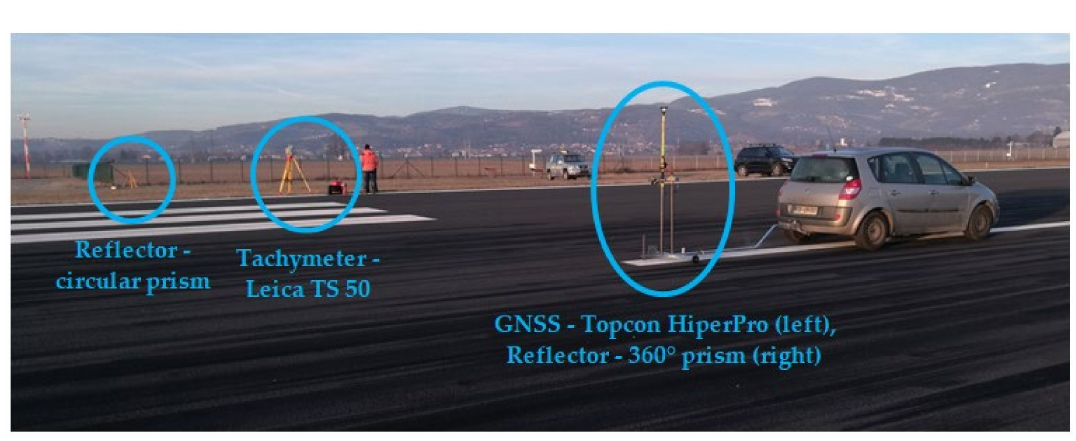
Figure 7. The used geodetic measurement